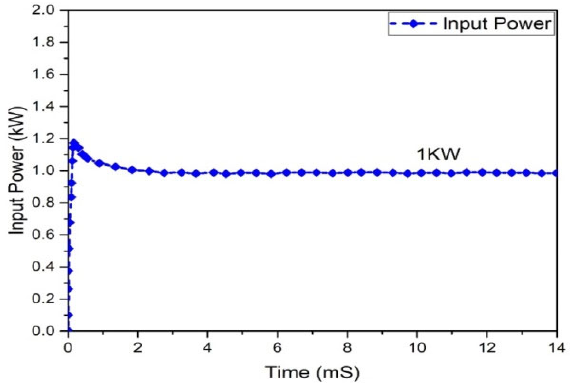
Figure 19. Input power analysis of interleaved boost converter.